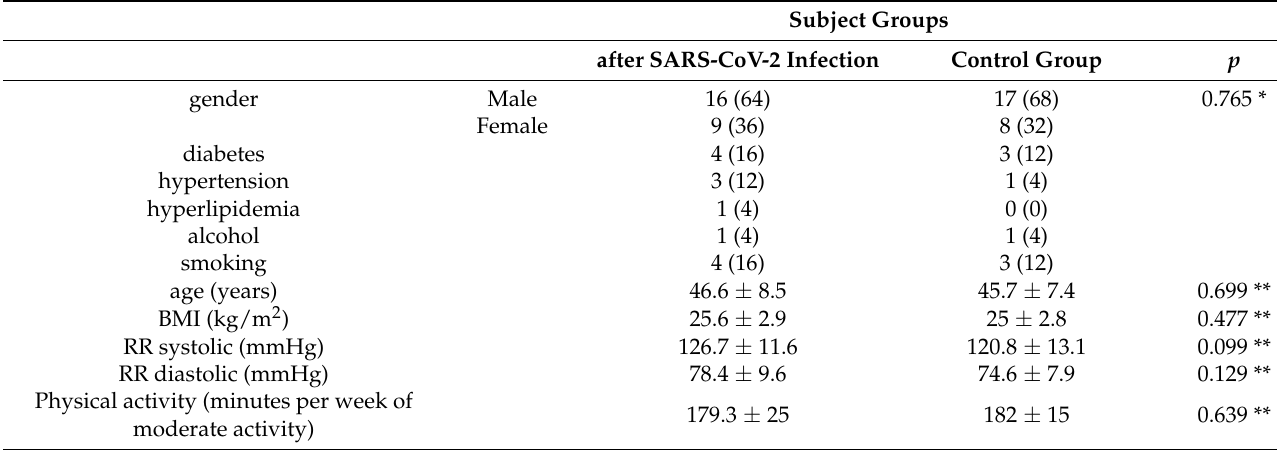
Table 2. Display of the number (%) of subjects according to qualitative data and arithmetic mean ± SD and quantitative data in relation to the examined groups (subjects after SARS-CoV-2 infection and subjects of the control group). Subject